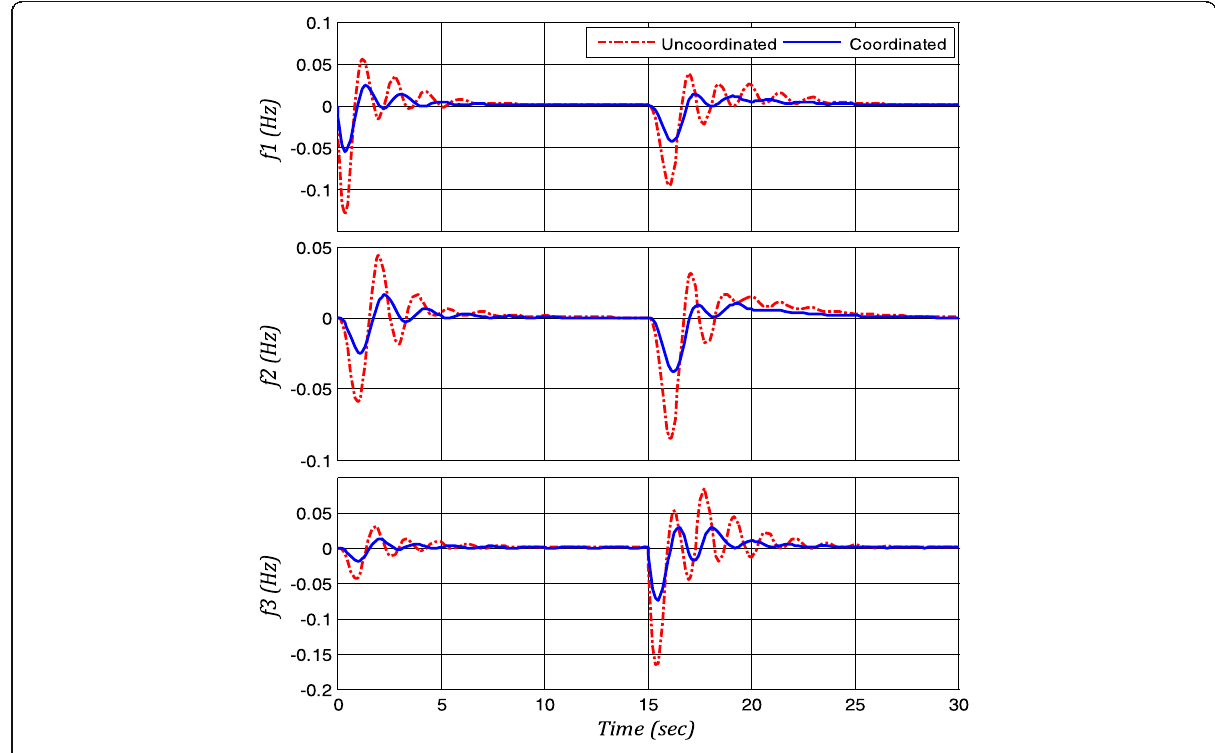
Fig. 4 Frequency deviations of the 3-CAs due to